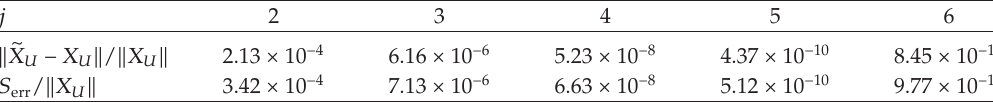
Table 1: Numerical results for the di ff erent values of j